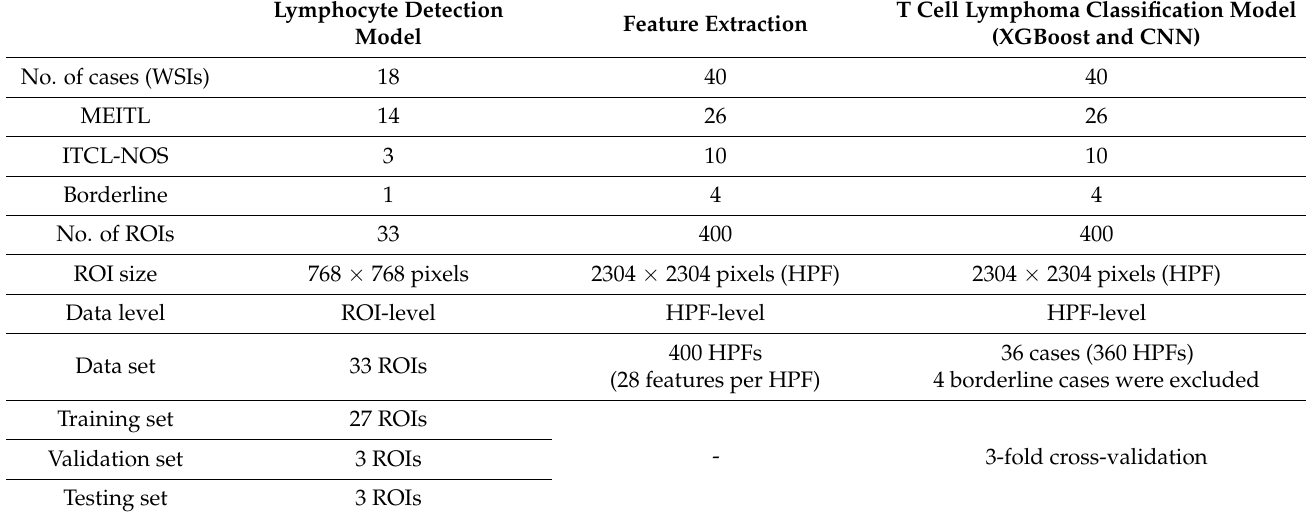
Table 2. Dataset used at each phase of machine learning model.